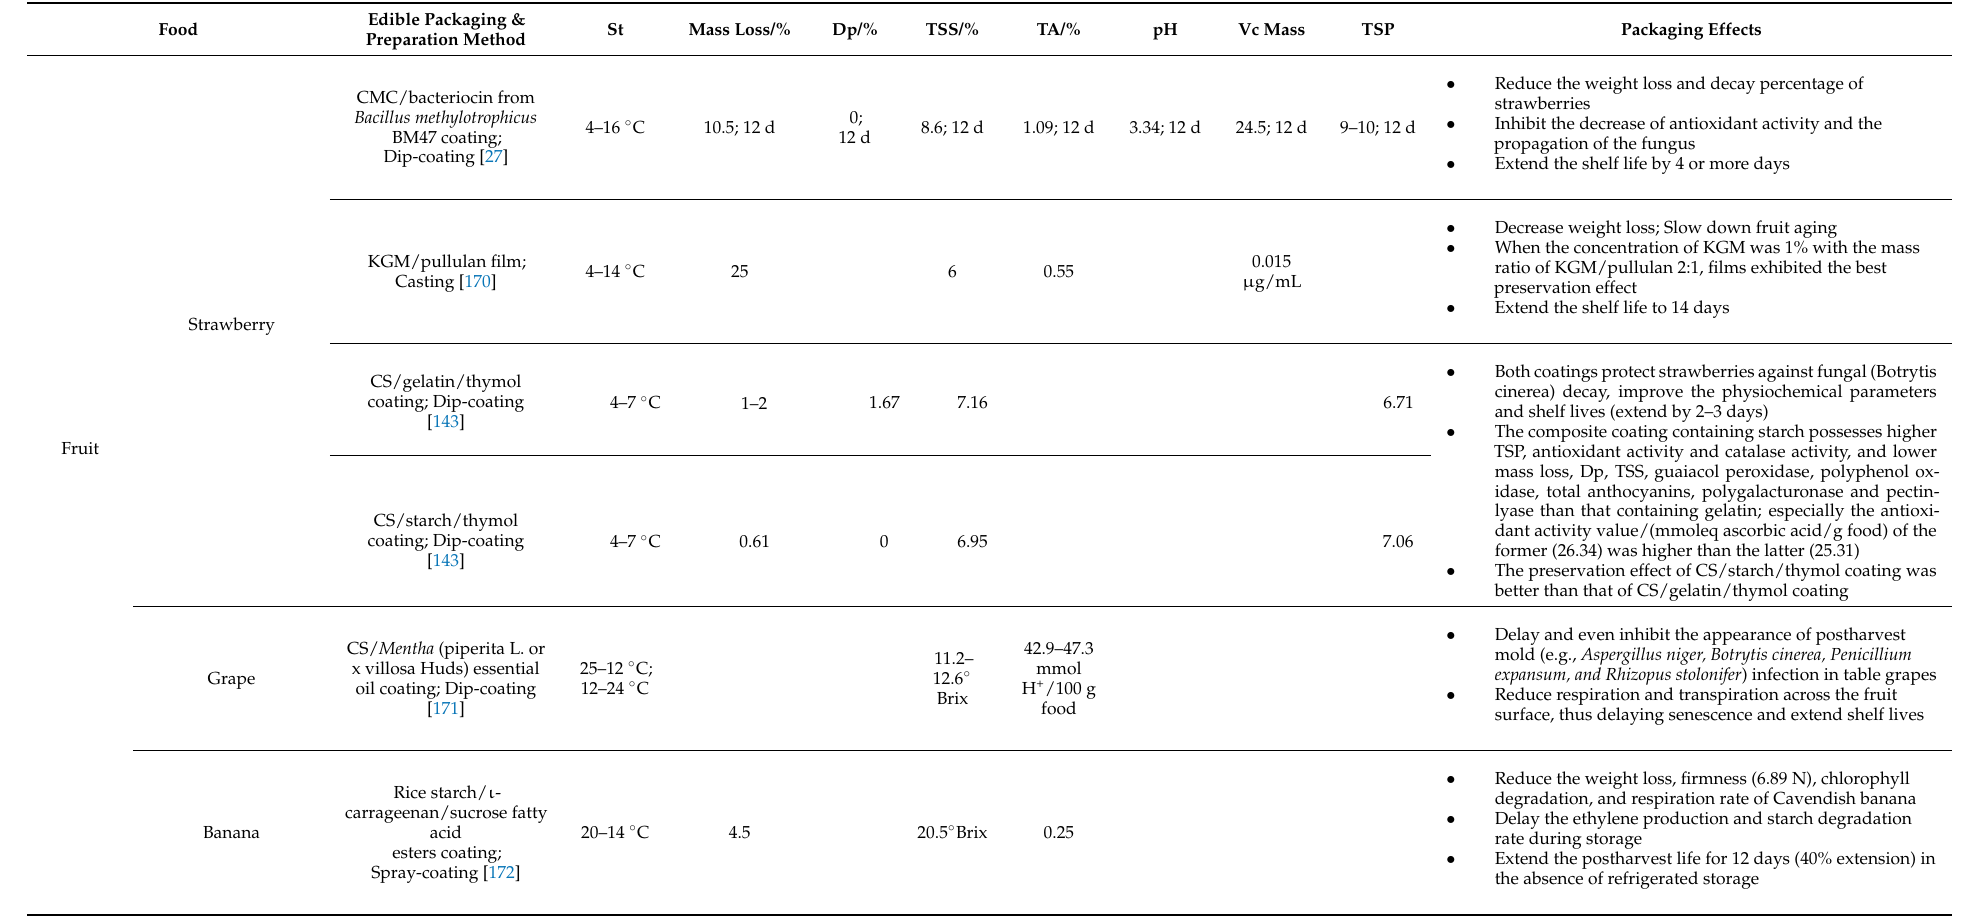
Table 4. Applications of five kinds of polysaccharide-based edible materials in food